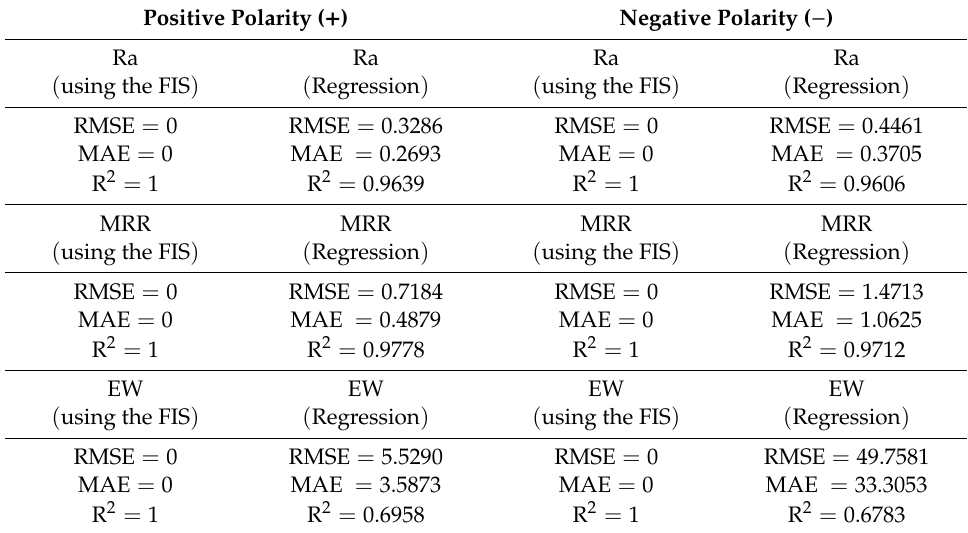
Table 4. Accuracy for predicted values of Ra, MRR, and EW using the regression model [2] and the